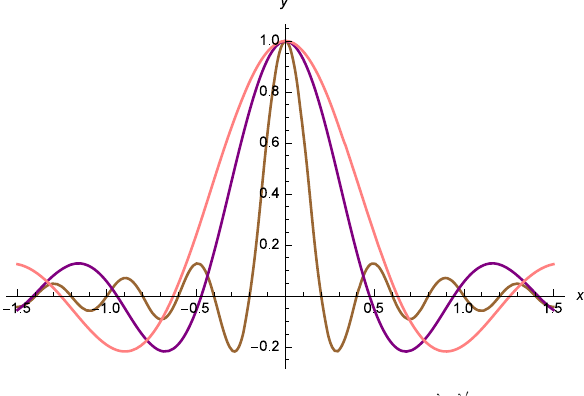
Fig. 1 Plot of y = (cid:5) ψ λ ( p ) | ψ λ (cid:10) ( p ) (cid:6) versus x = λ − λ (brown), Refs. [20,21] (purple) and GUP* (pink)